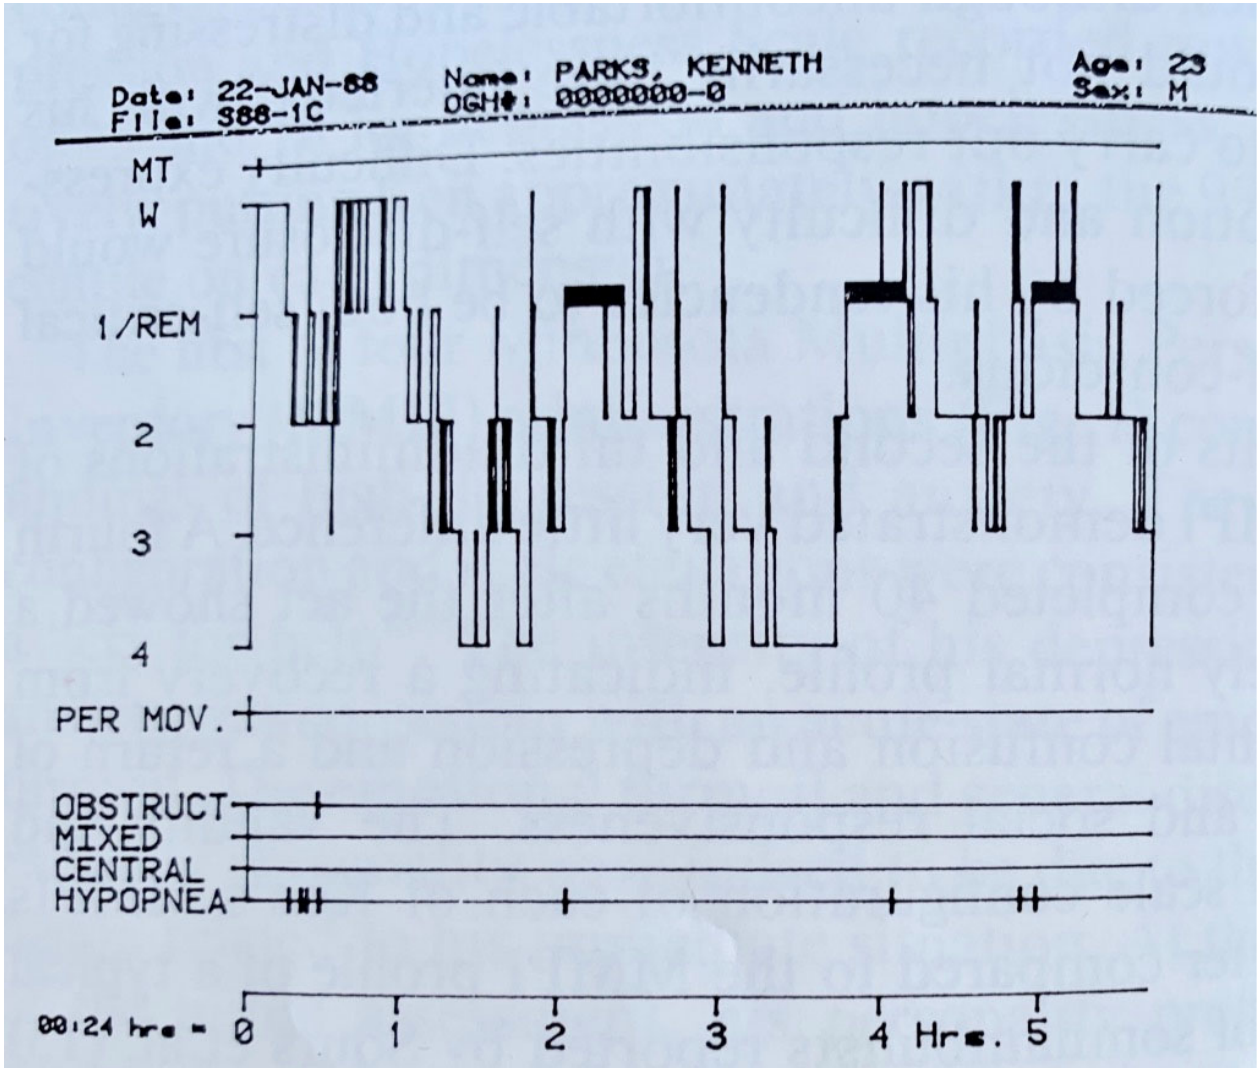
Figure 14. Histogram of the polysomnogram the night after the homicide of his mother ‐ in ‐ law by Ken Parks. Note the fragmented sleep and, especially, the presence of five awakenings from deep slow ‐ wave sleep (SWS). These occur at around 30 min, 2 h, 3 h, 4.5 h and 6 h after sleep onset. Normal subjects very rarely have direct arousals from sleep ‐ wave sleep to waking, and this pattern of multiple SWS arousals is characteristic in sleepwalkers. (Reproduced with permission from Broughton R., Billings R, Cartwright R et al. Homicidal Somnambulism: A Case Report. Sleep, Vol ‐ ume 17, Issue 3, May 1994, Pages 253–264, https://doi.org/10.1093/sleep/17.3.253, published by Ox ‐ ford University Press).